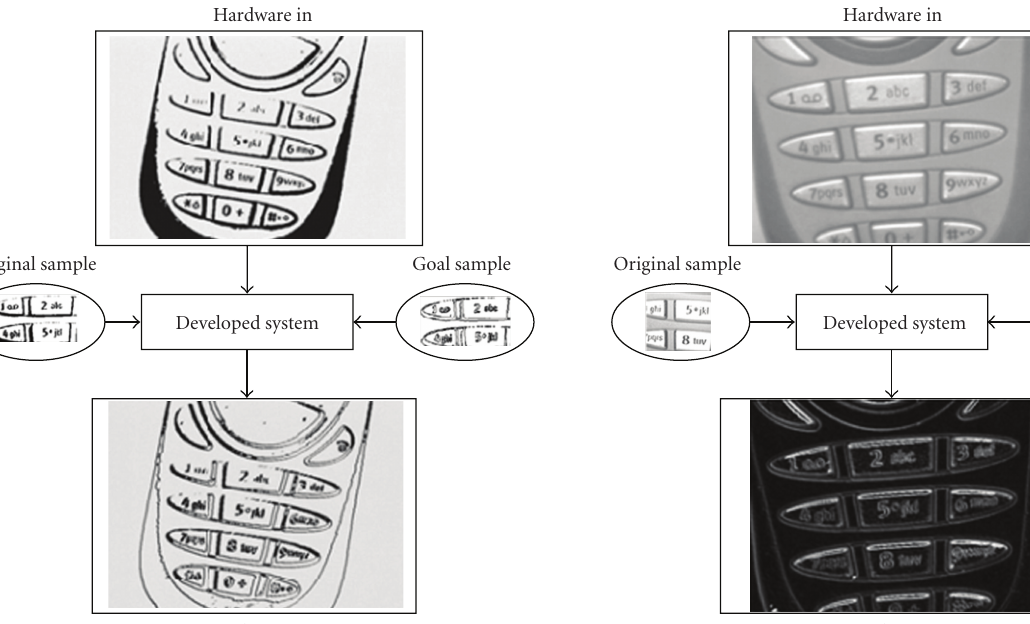
Figure 13: Emulation result of the Photoshop’s Trace Contour filter implemented in hardware.